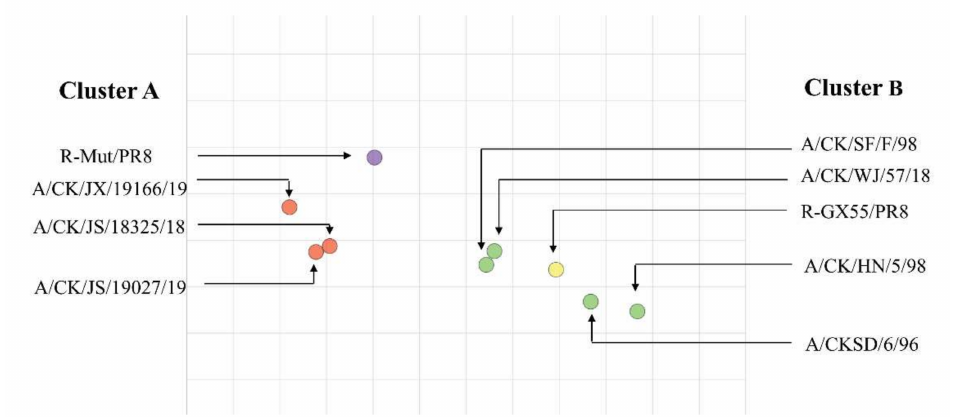
Figure 3. Antigen map of recombinant virus and wild-type strains. The solid circles indicated the positions of the virus. Clusters A and B were represented by red and green solid circles, respectively. R- Mut/PR8 and R-GX55/PR8 were represented by purple and yellow solid circles The spacing of the grid lines corresponds to the HI unit, which was equivalent to twice the difference in the HI